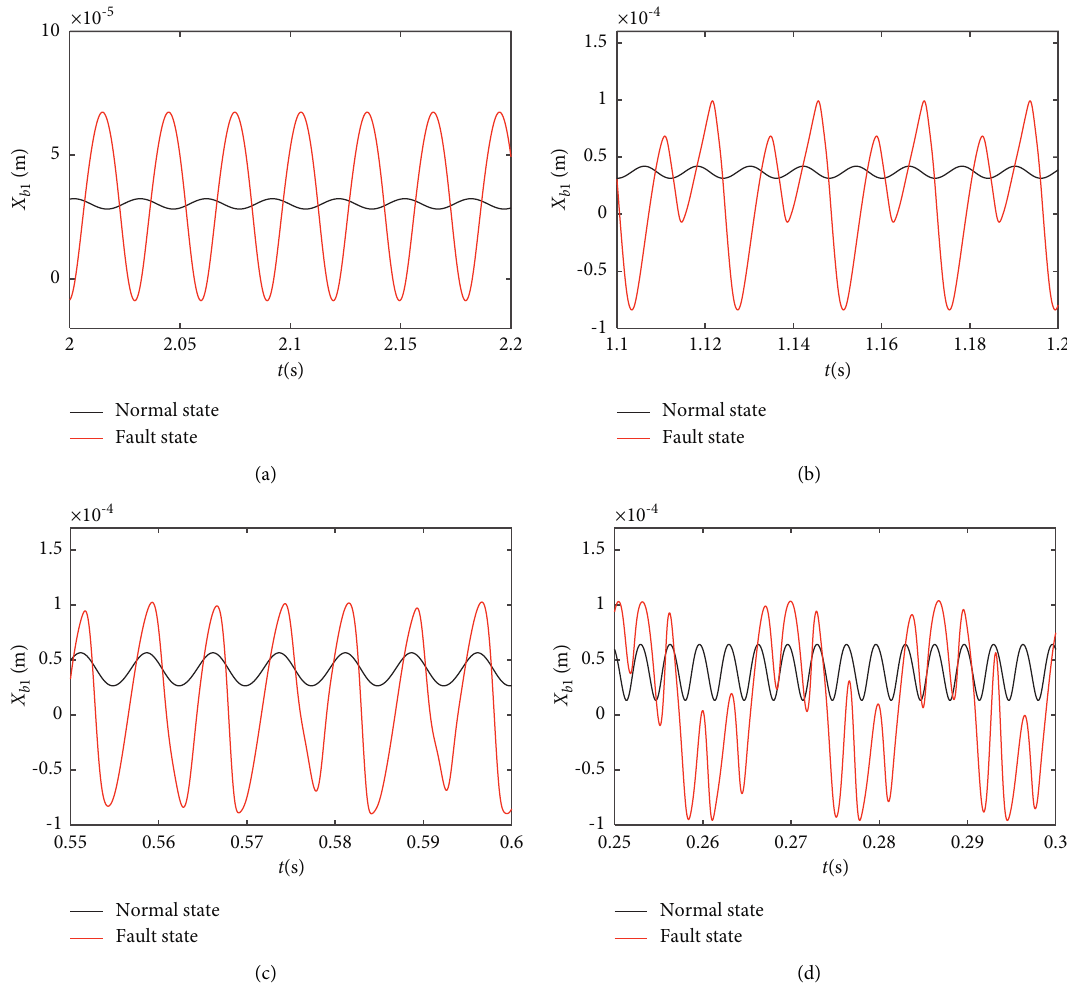
Figure 7: Time domain diagram of bearing vibration: (a) 2000rpm; (b) 5000rpm; (c) 8000rpm; (d)